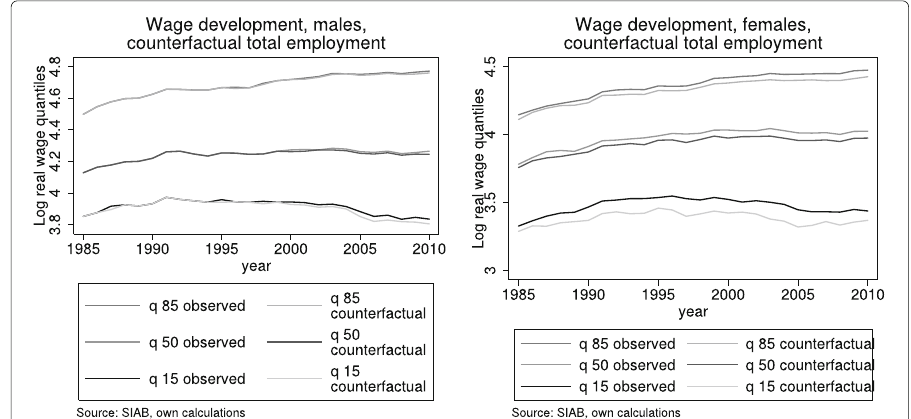
Fig. 14 Counterfactual wage distribution, if full-timers had total employment